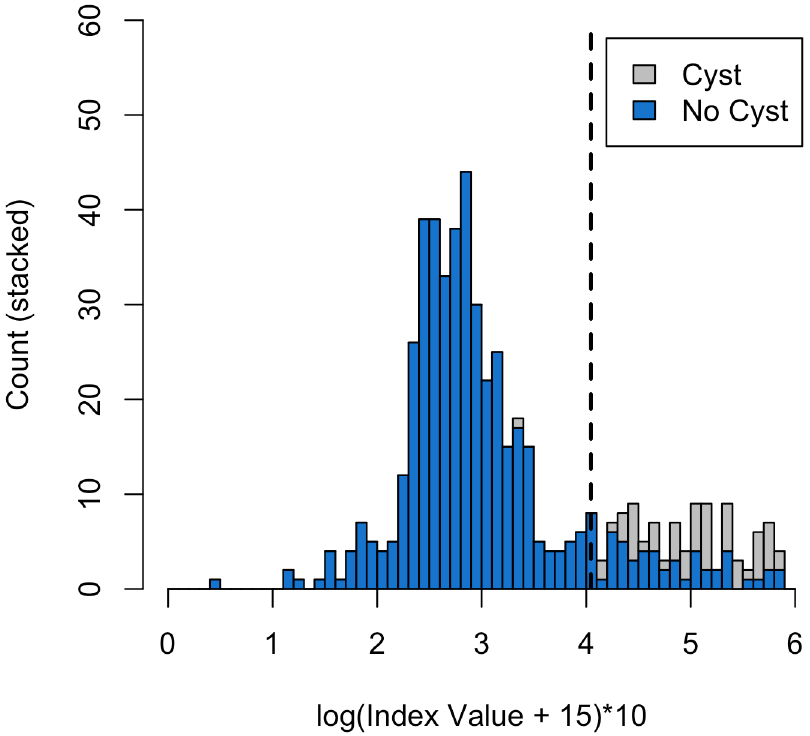
Fig 3. Counts of log sample index values (IVs) (the optical density of each sample indexed to the positive and negative controls on each plate) + a constant. Blue bars indicate samples from individuals without cysts, while grey bars indicate samplesfrom individualswith cysts. The dotted line indicatesthe optimalthresholdcutoff for positive samples indicating antigenpresencecalculatedwith the ROC analysis.